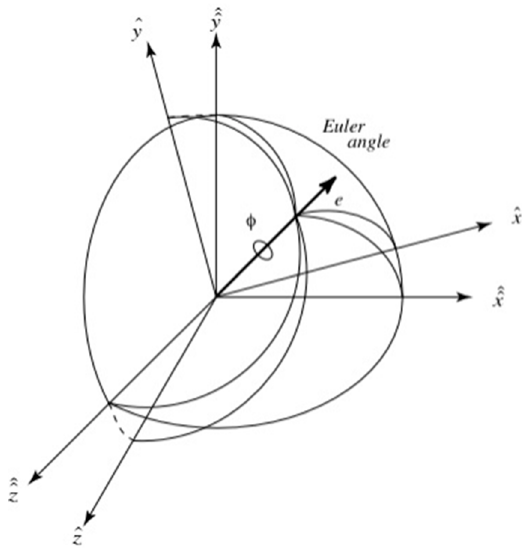
Figure 2. Euler parameters.